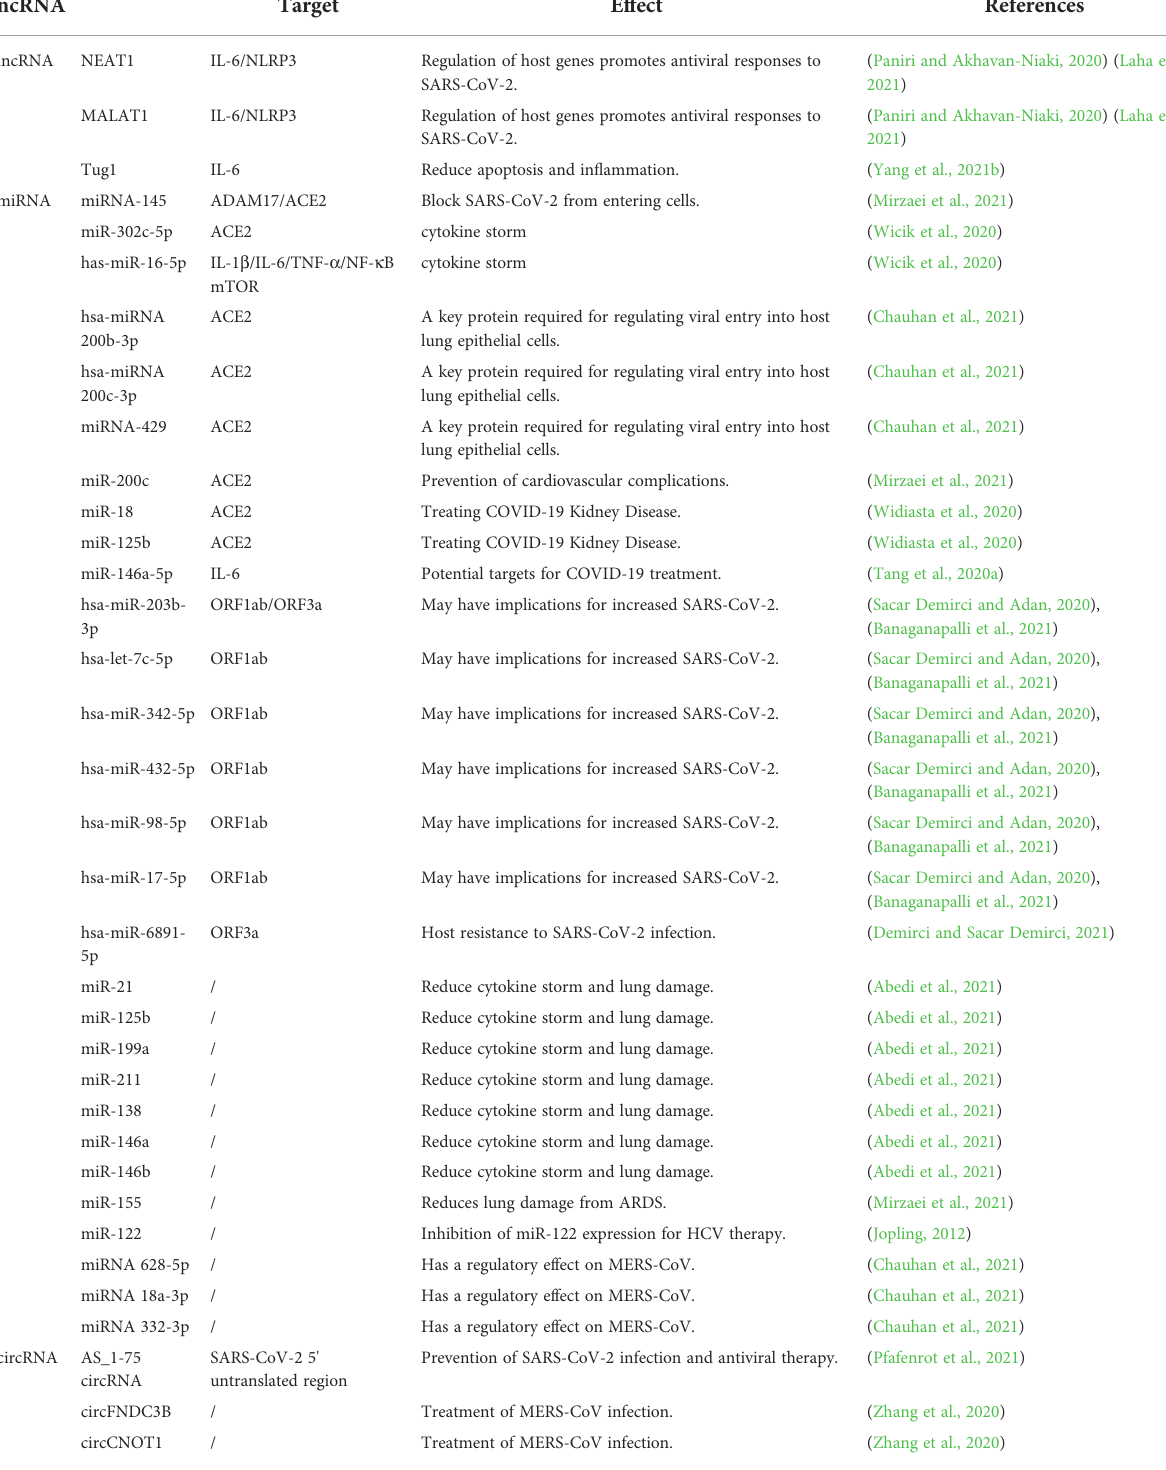
TABLE 3 Potential related therapeutic targets of lncRNA, miRNA and circRNA in